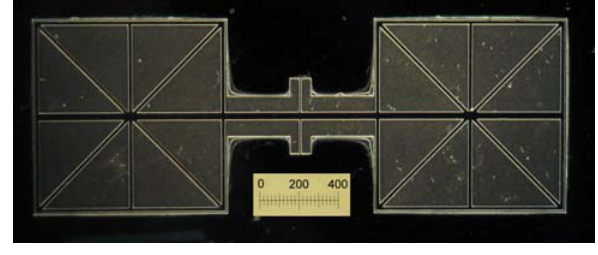
Figure 10. Micrograph of the acoustic pressure gradient sensitive